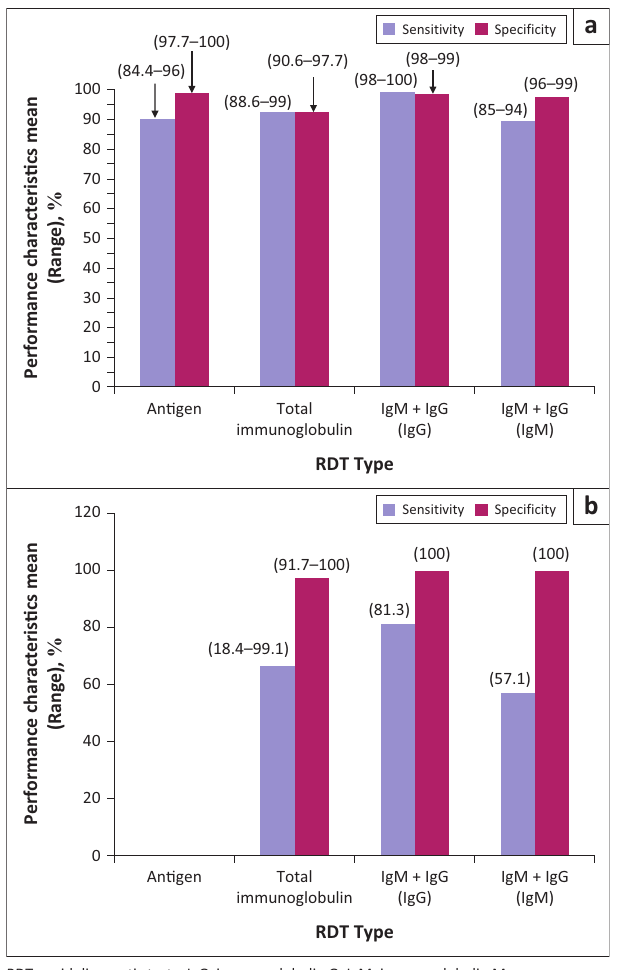
FIGURE 5: Performance characteristics of the different serological rapid diagnostic tests by testing platform; LFIA membrane (a) and colloidal gold devices